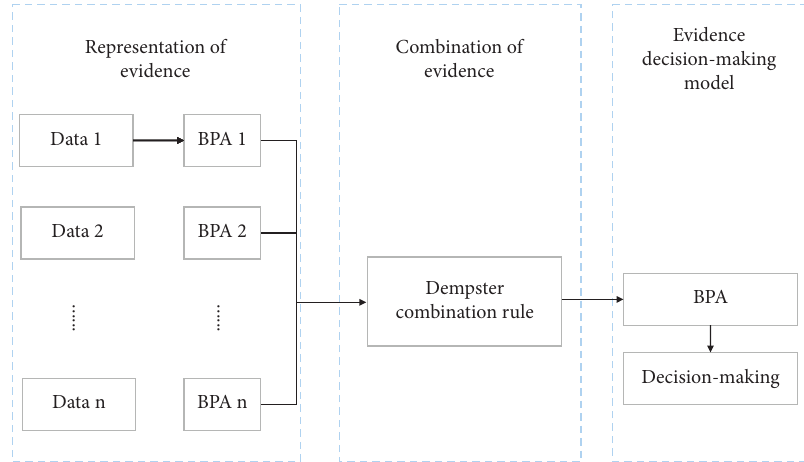
Figure 1: Framework of multisource information fusion based on D-S